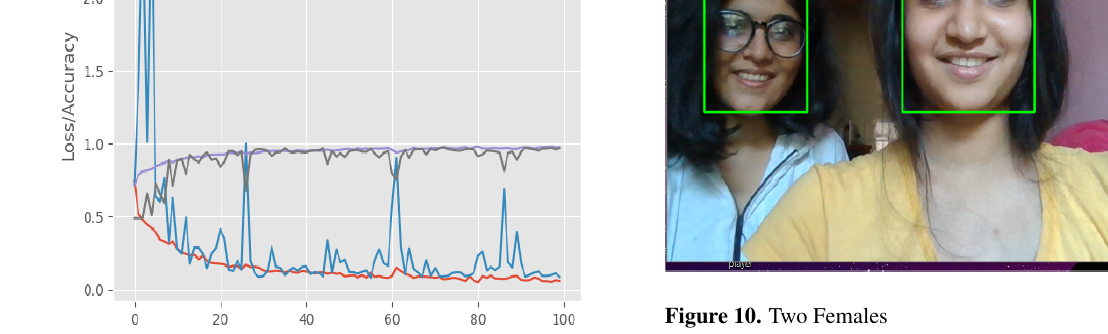
Figure 10. Two Females